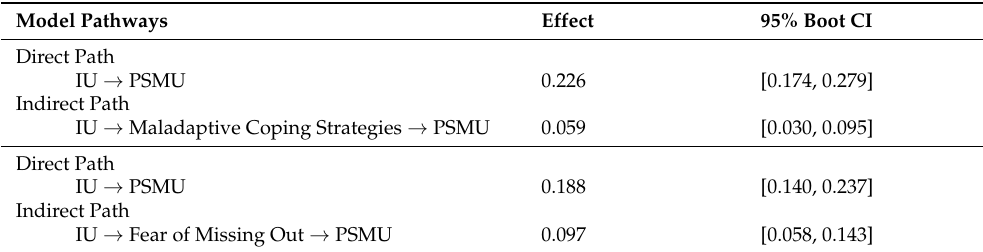
Table 2. Bias-corrected bootstrap test in mediating effect when maladaptive coping strategies/fear of missing out was entered as the mediation variable ( n =